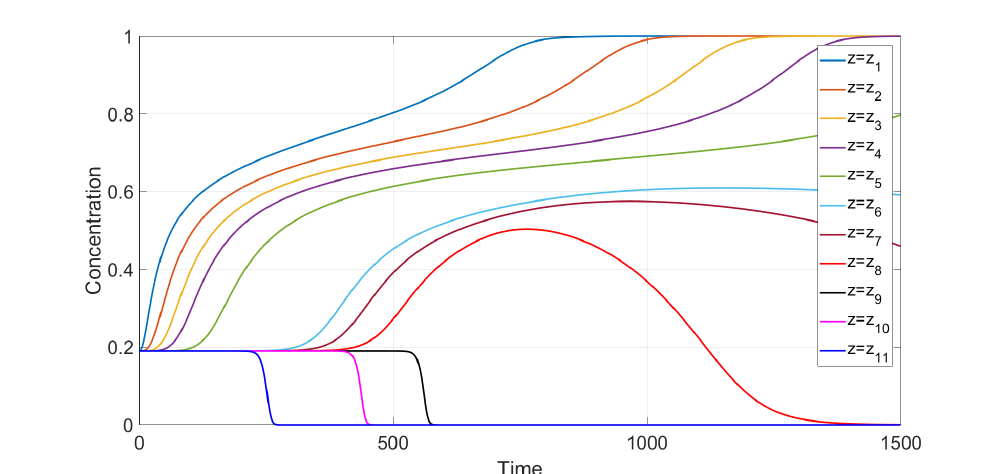
Figure 7. Calculated values of the average concentration versus time at different vertical locations for the shear thinning flux F sh ( c )